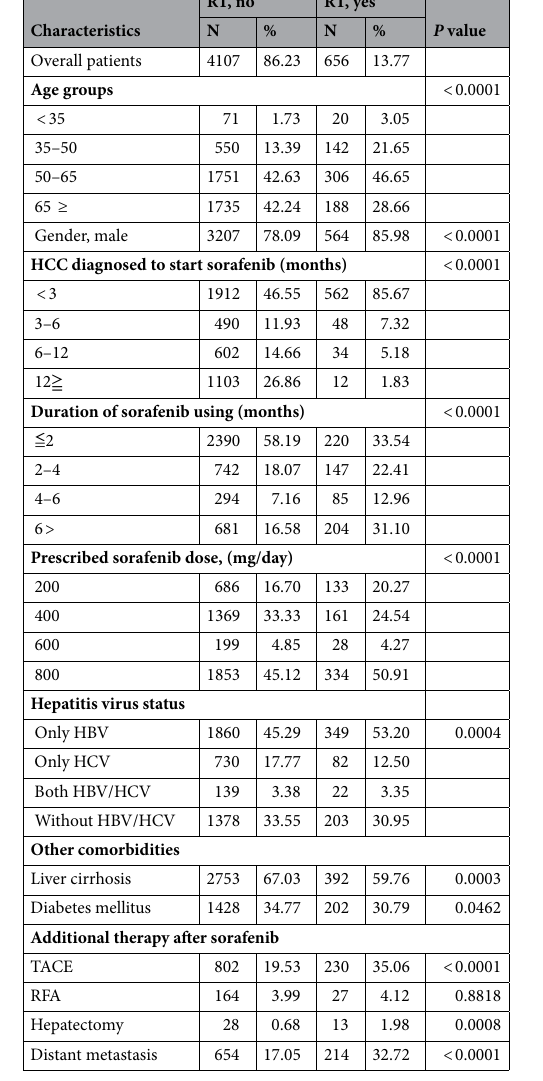
Table 1. Demographic information of advanced hepatocellular carcinoma patients receiving sorafenib combined with radiotherapy or not, n = 4763. RT radiotherapy, HCC hepatocellular carcinoma, HBV hepatitis B infection, HCV hepatitis C infection, TACE transarterial chemoembolization, RFA radiofrequency